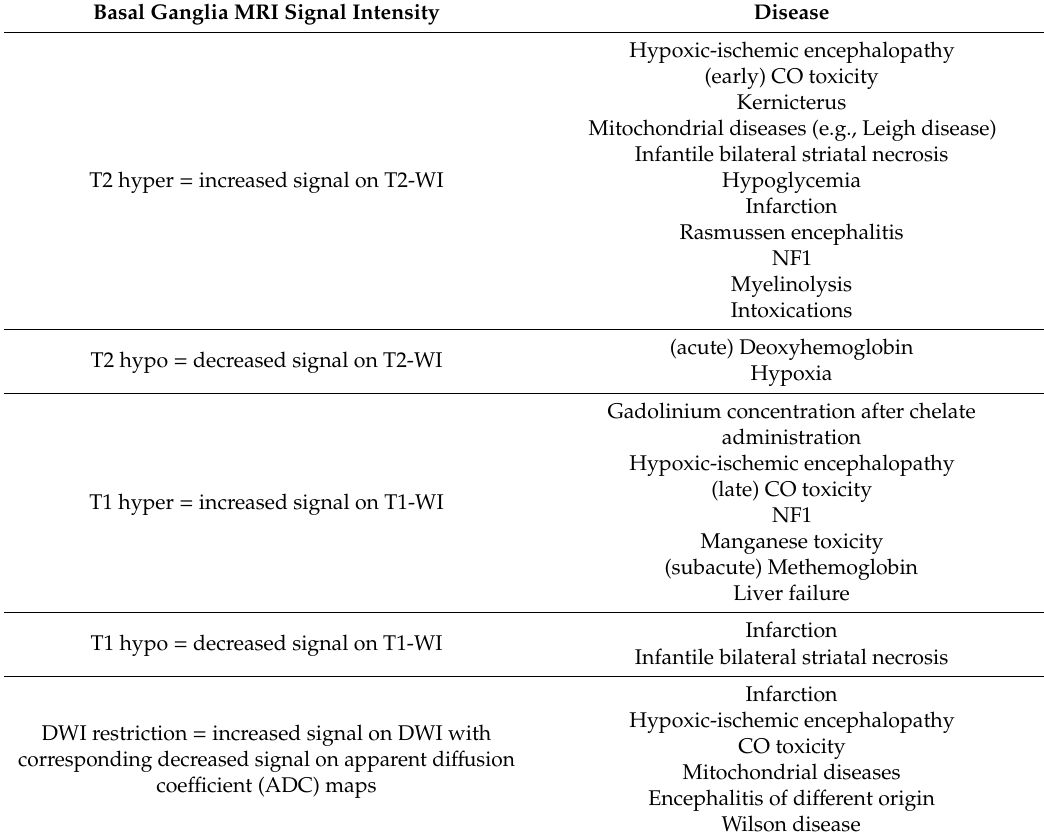
Table 1. Abnormal MR signal characteristics in particular sequences (T2-WI, T1-WI, DWI); metabolic diseases are given in bold